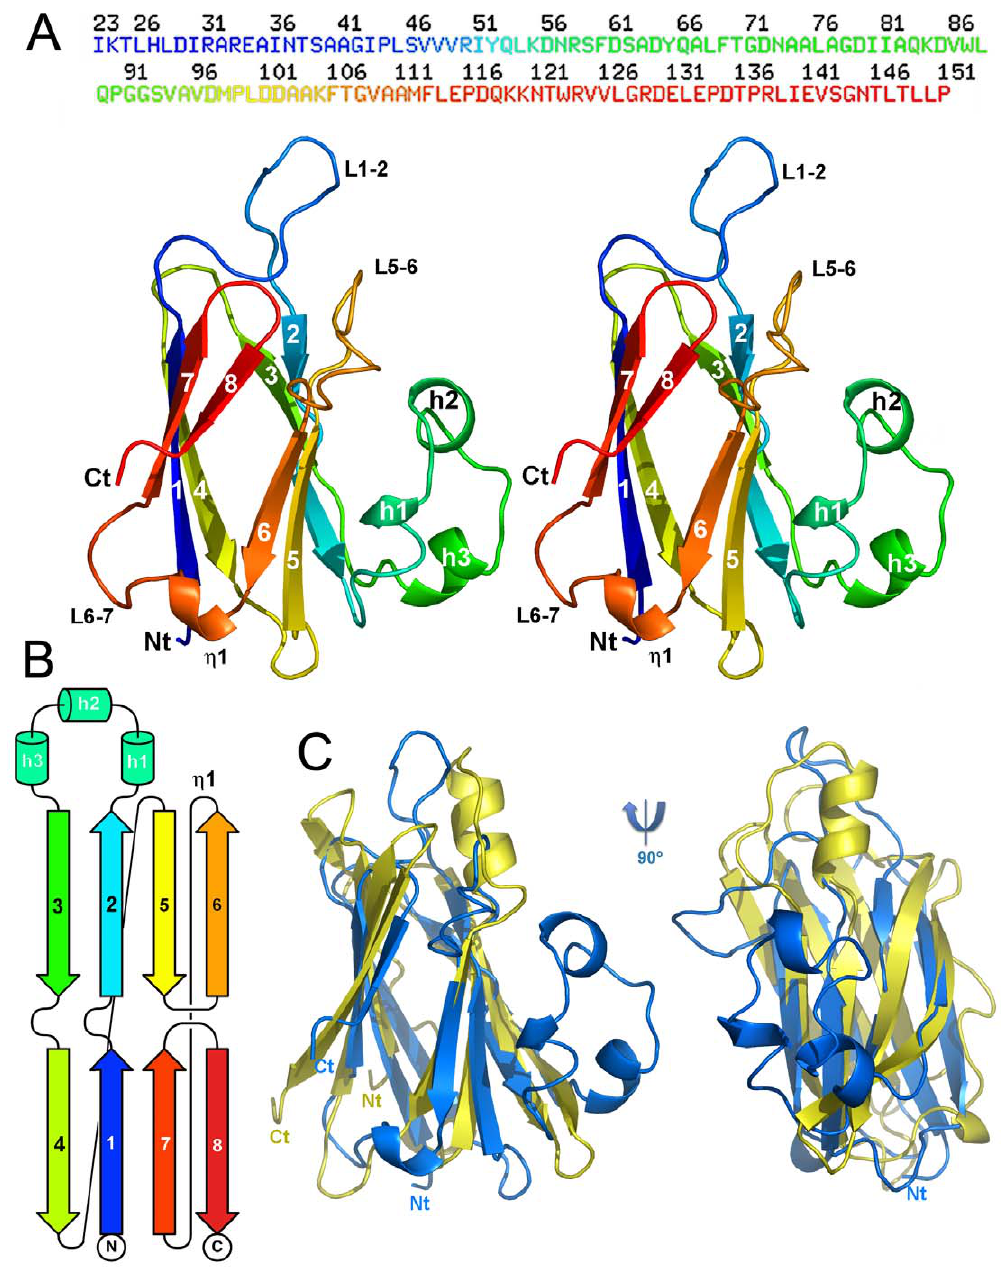
Figure 1. Structure of the enteroaggregative E.coli T6SS TssJ subunit. ( A ) Stereoview of TssJ in ribbon representation and rainbow coloring, from blue (N-term) to red (C-term); the sequence is represented above. Figure made with Pymol [61]. ( B ) Topology cartoon of TssJ (same coloring as in (A)). ( C ) Structural comparison of TssJ and its nearest homologue, transthyretin (1sn5), after superimposition. The topology is identical for both proteins and their b -sandwiches superimpose within 3.2 A˚. Note the presence of an extra helical domain in TssJ, and an extra helix (top)